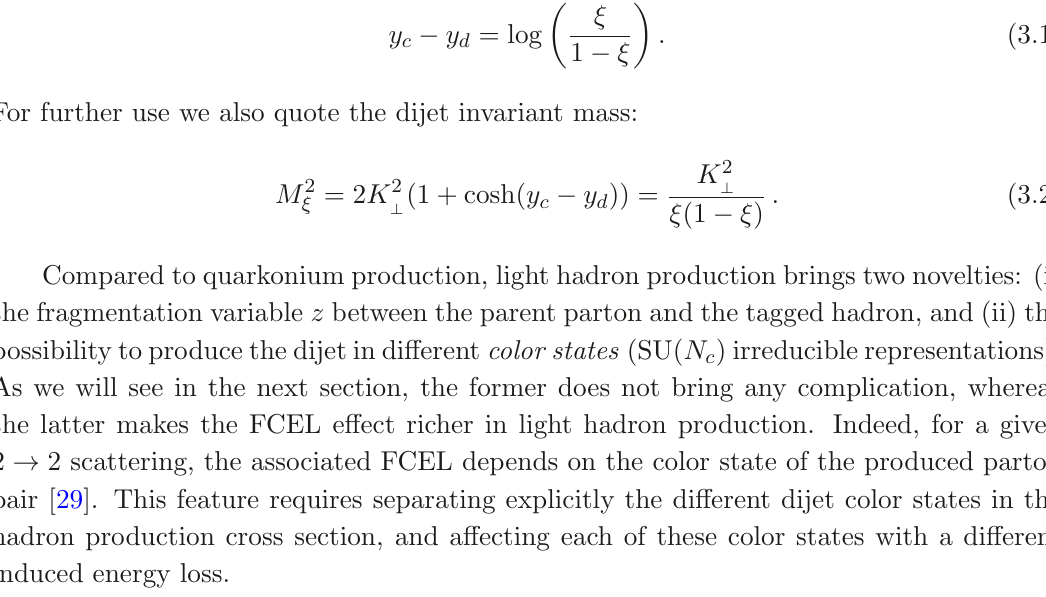
Figure 1 . Contribution to light hadron production in pA collisions from the partonic process ab cd , as viewed in the nucleus rest frame, followed by the fragmentation c ! here) or d h . In addition to the incoming parton b , the nucleus provides the nuclear broadening ! ‘ arising from parton multiple ? A